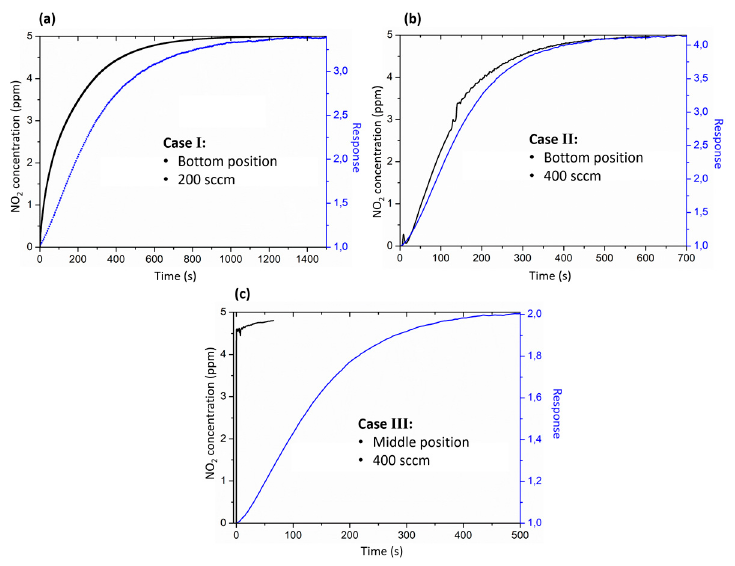
Figure 1. Simulated NO 2 concentration arriving at the sensor surface and response of the sensor for 5 ppm of NO 2 at 300 °C for: ( a ) at the bottom of the chamber and with 400 sccm of flow; ( b ) at the bottom of the chamber and with 200 sccm of flow and ( c ) at the middle of the chamber and with 400 sccm of